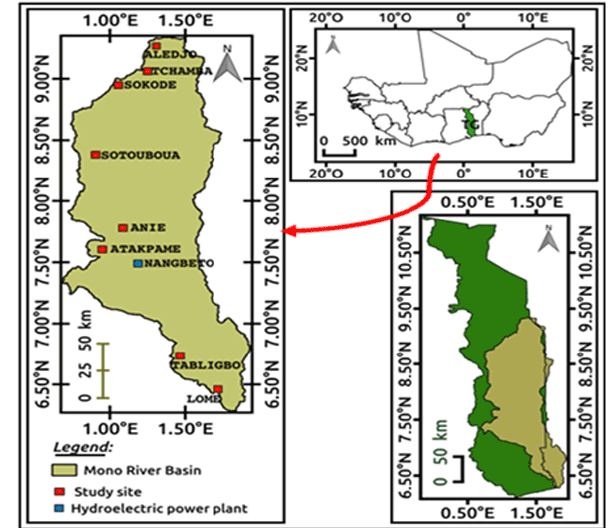
Figure 1. Study area location and considered stations (sources Bat- ablinlè et al.,